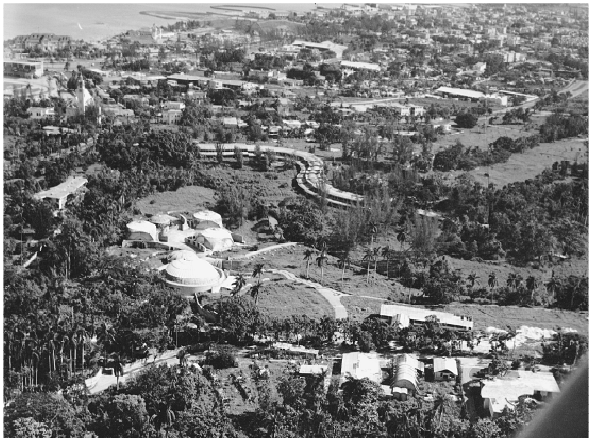
Figure 2. Ballet and Music School during their construction (ISA Archive,